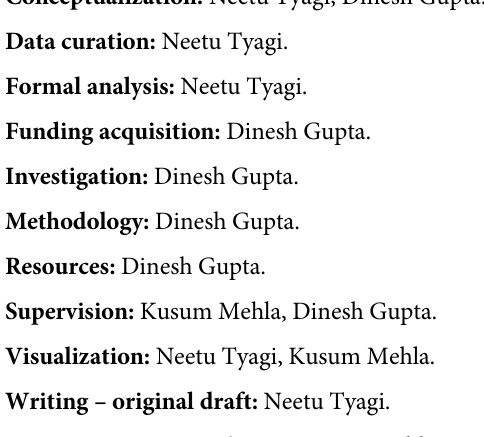
S3 Fig. Protein-Protein Interaction networks of DEGs for RA. (a) Upregulated RA genes, (b) Downregulated RA genes. The size and the colour of the nodes are layout by the degree and betweenness values. S4 Fig. Protein-protein interaction networks of DEGs for SLE. (a) Upregulated SLE genes, and (b) Downregulated SLE genes. The size and the colour of the nodes are layout by the degree and betweenness